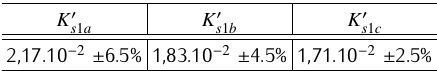
Figure 7. 17 days of strain records at MOK, june 2010. (a) Observed strain on each component corrected for the linear trend. The diurnal and semi-diurnal tide effects are clearly visible. (b) Solid tidal strain predicted for each gauge orientation (relation 1). Note that this solid strain prediction shows a smaller semi-diurnal to diurnal ratio than the record, as the true record has a strong additional contribution from the local sea level at semi-diurnal periods.